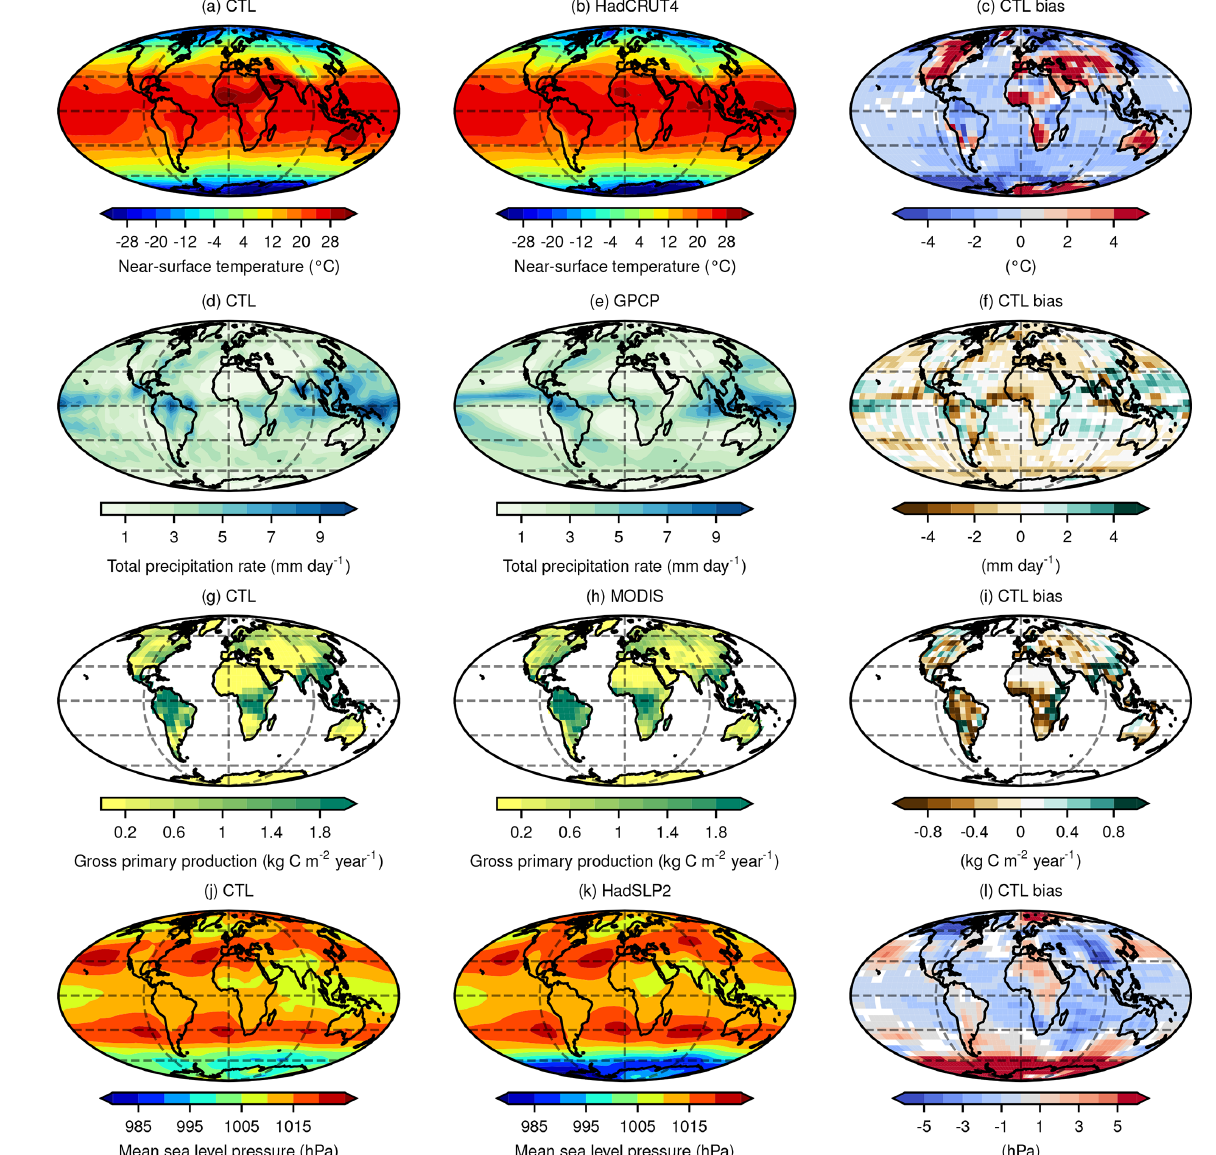
Figure 3. Annual mean results for the CTL simulation compared with observational data: near-surface temperature in CTL (a) and Had- CRUT4 (b) and model bias (c) ; total precipitation in CTL (d) and GPCP (e) and model bias (f) ; GPP in CTL (g) and MODIS (h) and model bias (i) ; and mean sea level pressure in CTL (j) and HadSLP2 (k) and model bias (l) . In the bias panels, white depicts grid points with statistically non-significant difference ( α = 0 . 05). Grid lines are spaced every 30 ◦ from the Equator and 90 ◦ from Greenwich, in latitude and longitude,